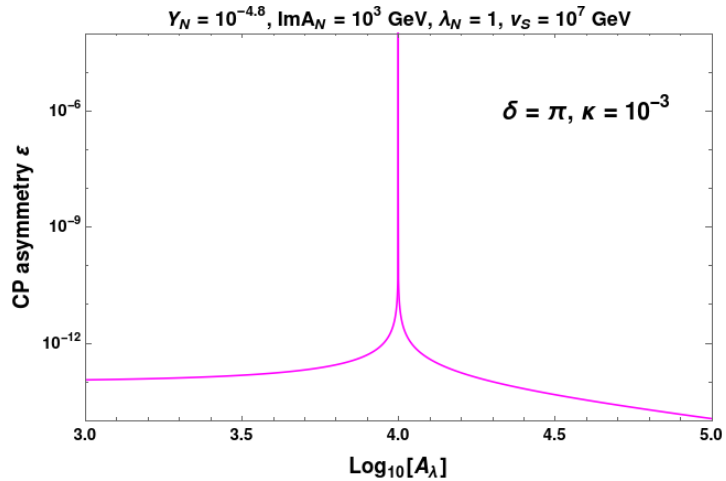
Figure 7 . Variation of " versus A (cid:21) in the (cid:14) = (cid:25) limit. The resonance in " occurs when A (cid:21) = (cid:20)v S . masses and phase space factors for boson and fermion (cid:12)nal states without which there is no asymmetry. In the NMSSM where the singlet scalar S takes a vev, an asymmetry can be generated even without any thermal phase space/mass corrections to the decay